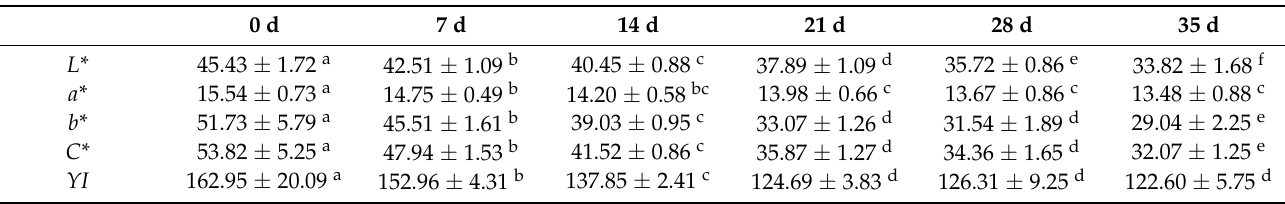
Table 1. Changes in the color parameters during